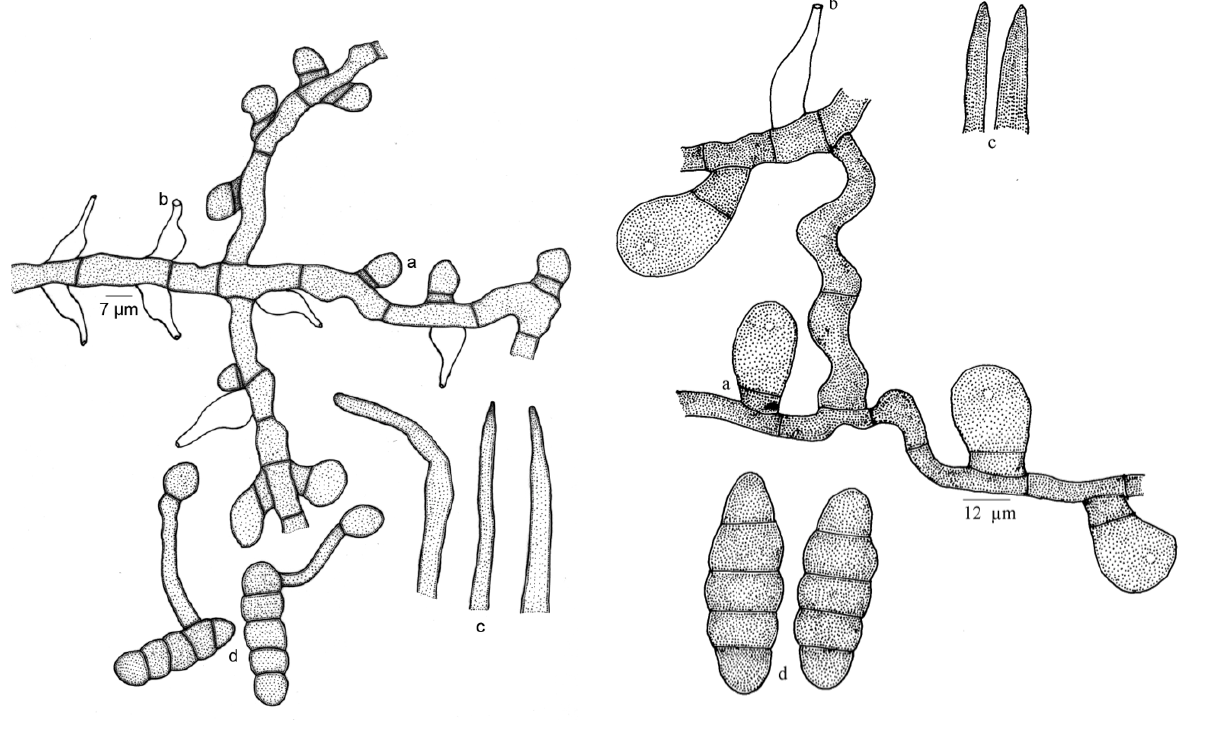
Figure 111. Meliola pushpangadanii a - Appressorium; b - Phialide; c - Apical portion of mycelial setae; d -